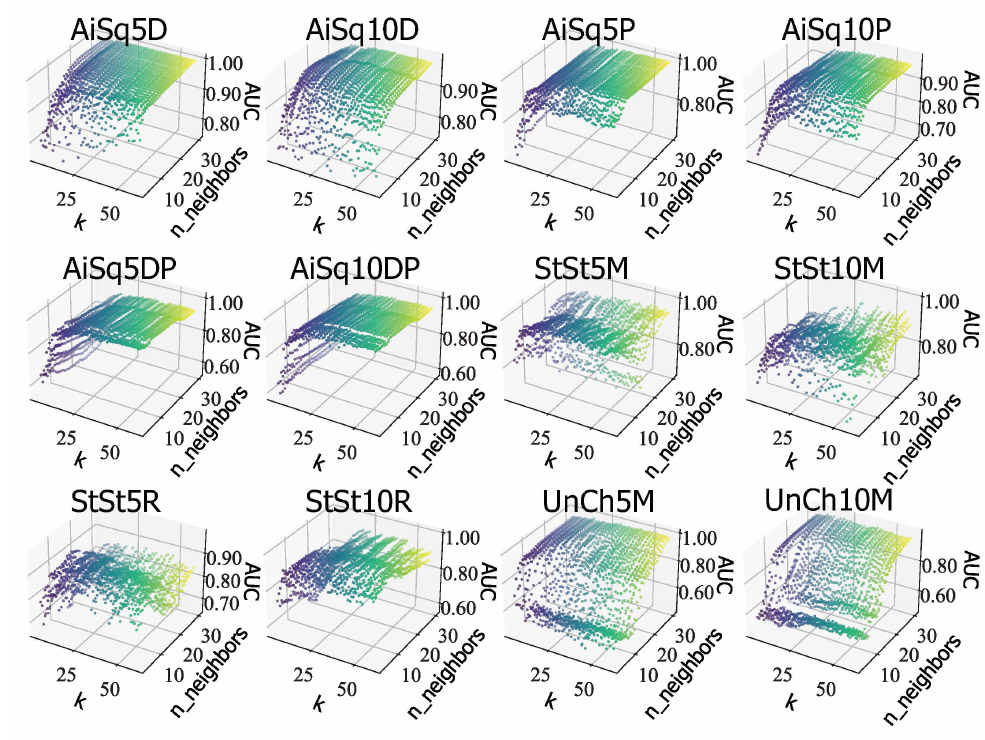
Figure 10. Results when tuning both k for MiPo and n _ neighbor for LOF at the same time. Good results could be obtained by setting larger values for both k and n _ neighbor